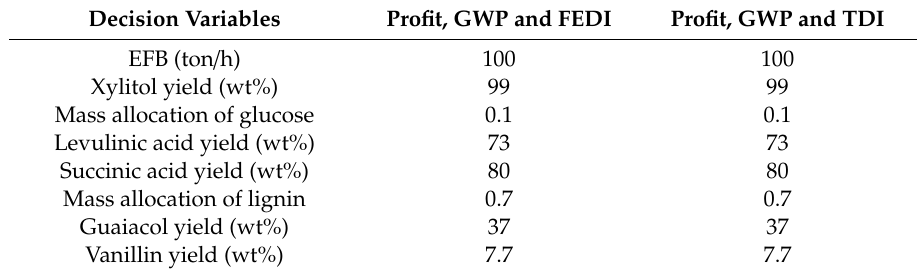
Table 13. Decision variables that correspond to the selected Pareto-optimal solutions in Figure 13. Table 14. Optimal objective values for the selected Pareto-optimal solutions in Figure